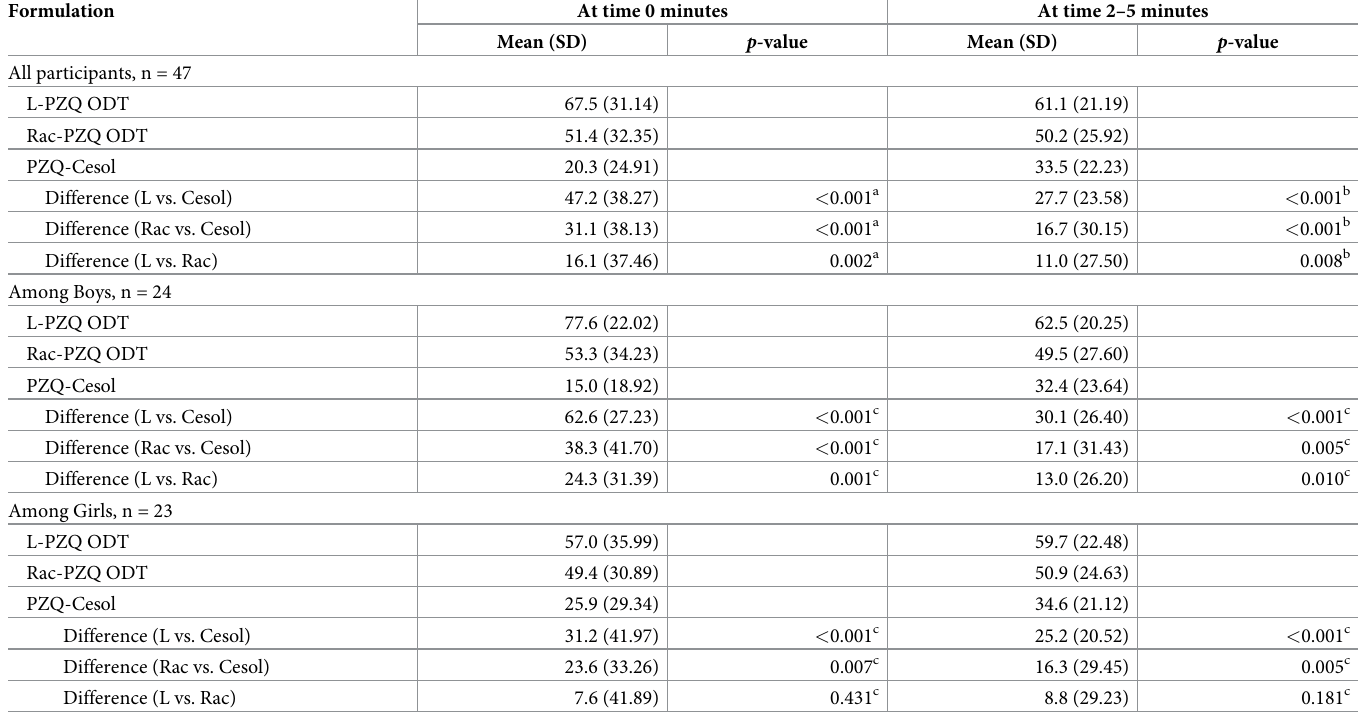
Table 3. VAS scores (mm) for L-PZQ ODT dispersed in water and Rac-PZQ ODT dispersed in water relative to current PZQ-Cesol crushed in water, at time 0 and 2–5 minutes and stratified by gender.